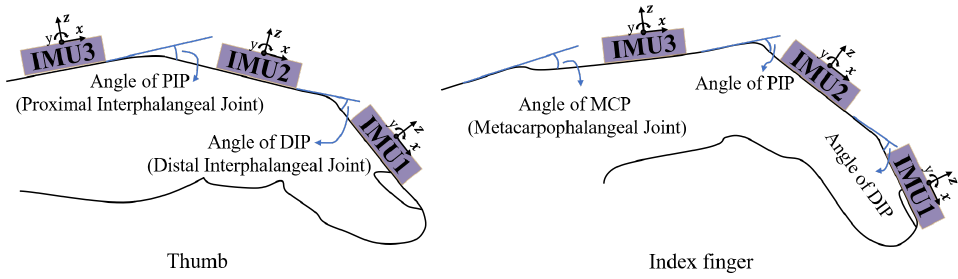
Figure 6. IMU orientation and angles of finger interphalangeal joints for the thumb and index finger.